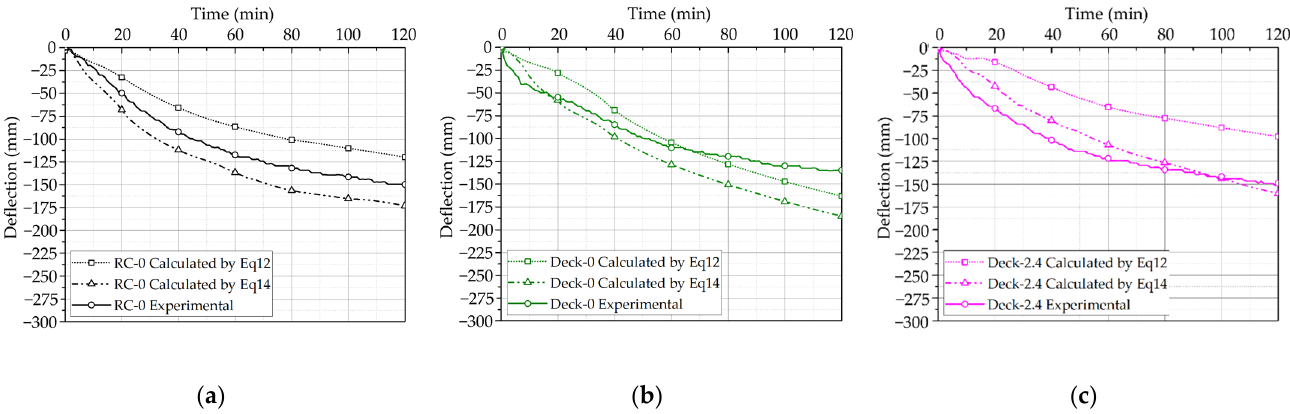
Figure 9. Deflection of specimens. ( a ) Deflection of RC-0. ( b ) Deflection of Deck-0. ( c ) Deflection of Deck-2.4.